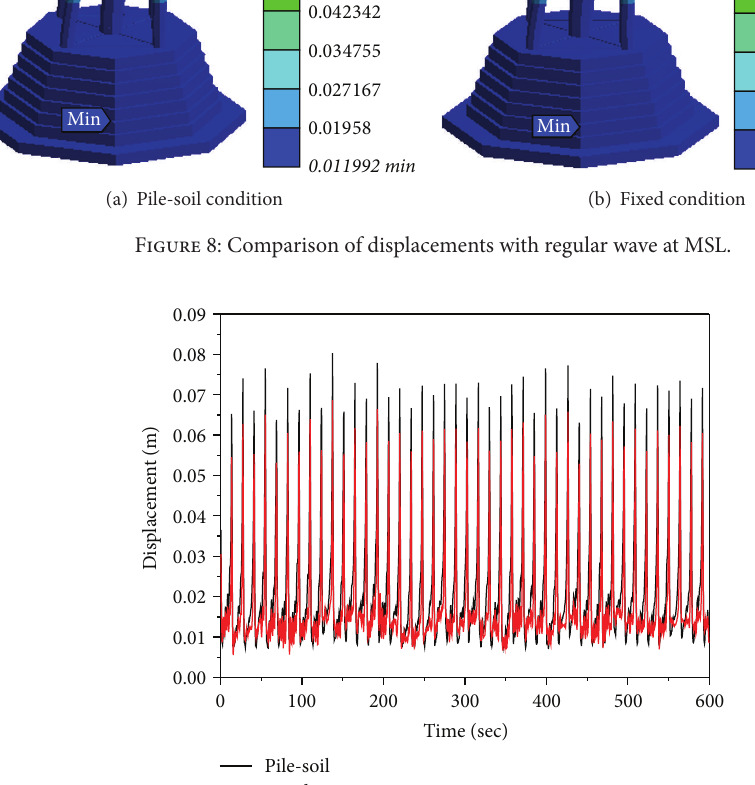
Figure 9: Maximum displacements with regular wave at MSL.